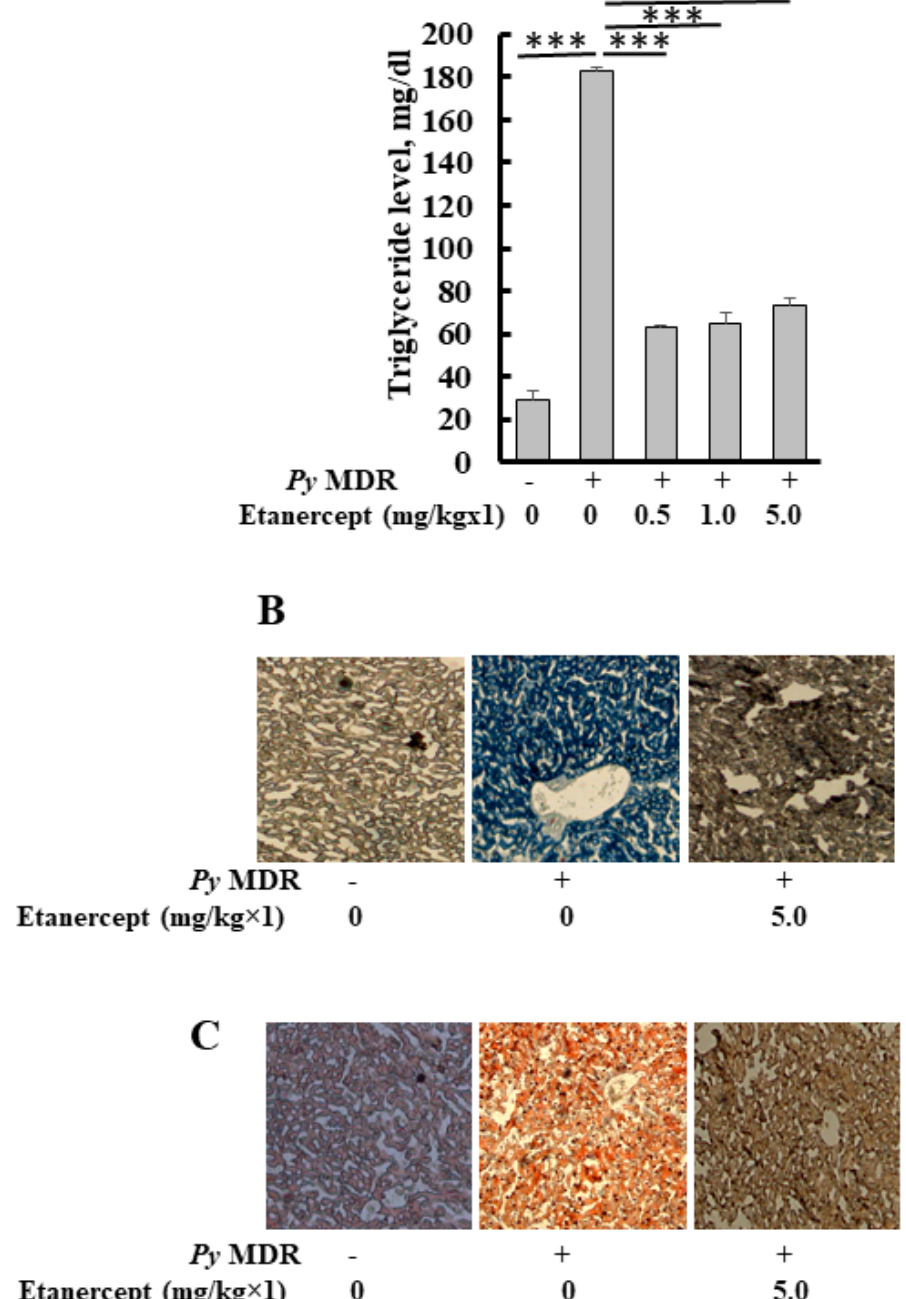
Figure 3. Quantification of triglyceride, oil red O and Sudan black B staining of liver sections. ( A ) Level of triglyceride in the liver after prophylactic treatment of Etanercept ( B , C ). Images show representative oil red O stained ( B ) Sudan black B ( C ) liver section from uninfected P. yoelii MDR-infected and Etanercept, 5 mg/kg × 1 treated mice groups. ( p *** < 0.0001). During malaria infection, histological changes in the liver of infected mice were similar to the dilatation of sinusoids, a distorted network of hepatocytes, and deposition of hemozoin. Etanercept was administered subcutaneously, followed by infection to prove the role of TNF- α in stimulated lipid deposition during infection, which leads to tissue damage. Our previous results indicated that the inhibitor was capable of reducing the lipid deposition.